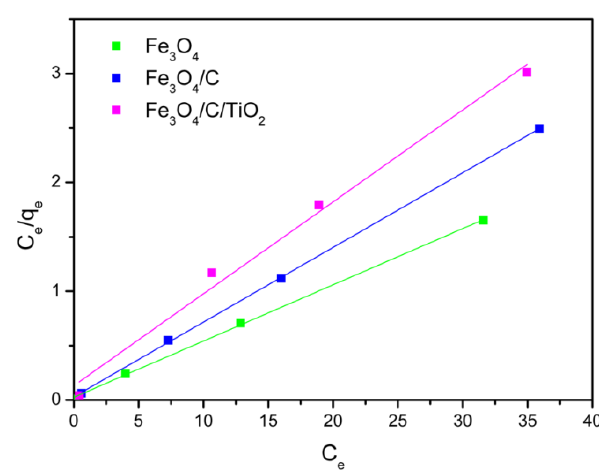
Figure 7. Langmuir isotherm plots for As(V) adsorption by Fe 3 O 4 , Fe 3 O 4 / C, Fe 3 O 4 / C / TiO 2 at 25 ◦ C. Table 3. Parameters of the Langmuir equation for tested adsorbents used for adsorption of As(V) ions. Adsorbent Q m (mg / g) K L (L / mg)